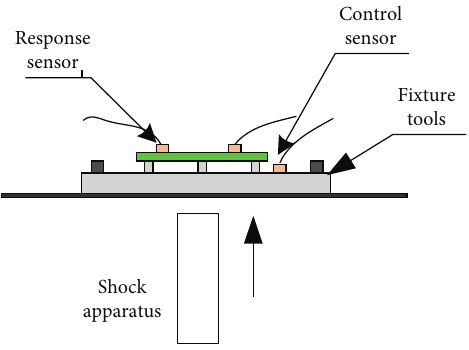
Figure 8: Sketch of the experiment